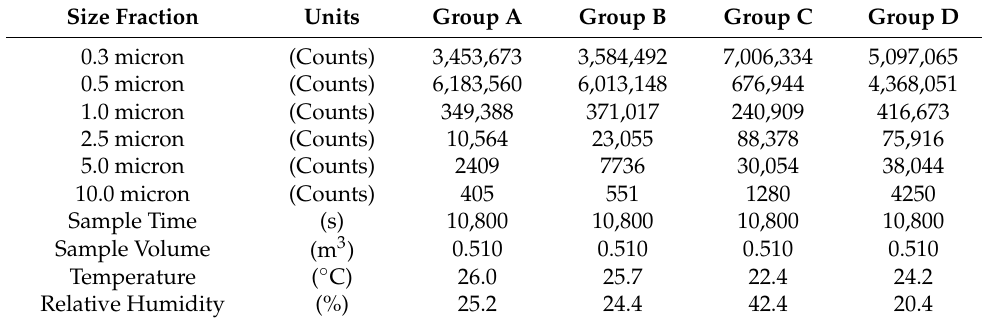
Table 3. Particle counts and indoor microclimate recorded using the Lighthouse HH 3016 IAQ.